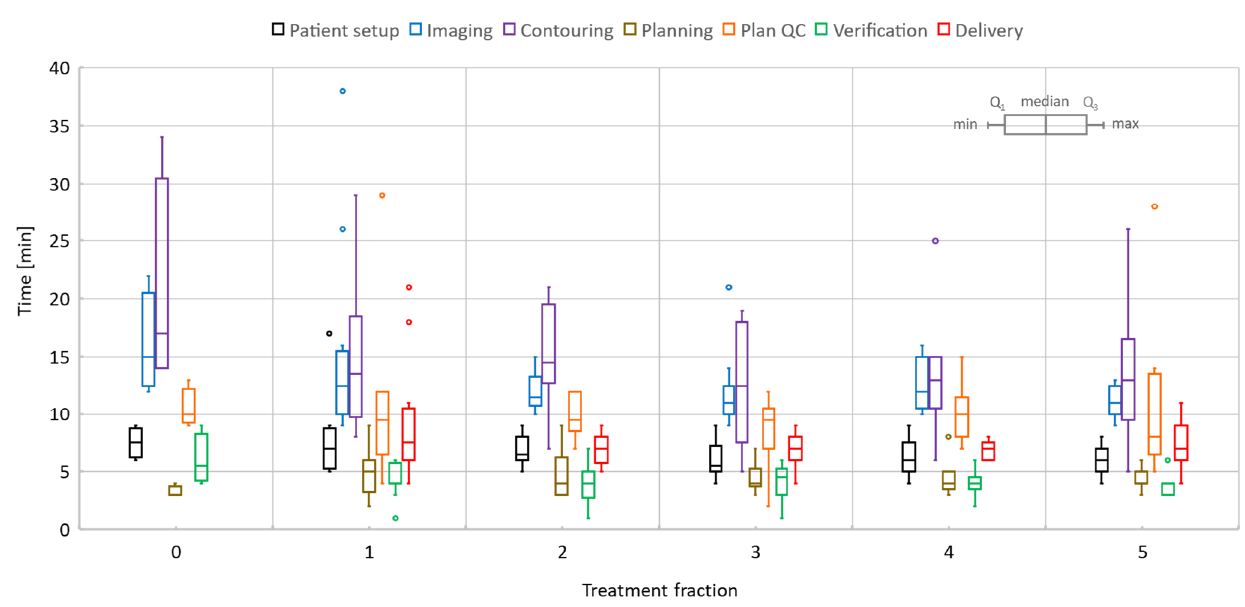
Figure 7. Liver online adaptive sessions for Fractions 1 and 5 and including the dry-run (or Day 0) session where available. The time required to perform key processes in the adapt-to-shape workflow.